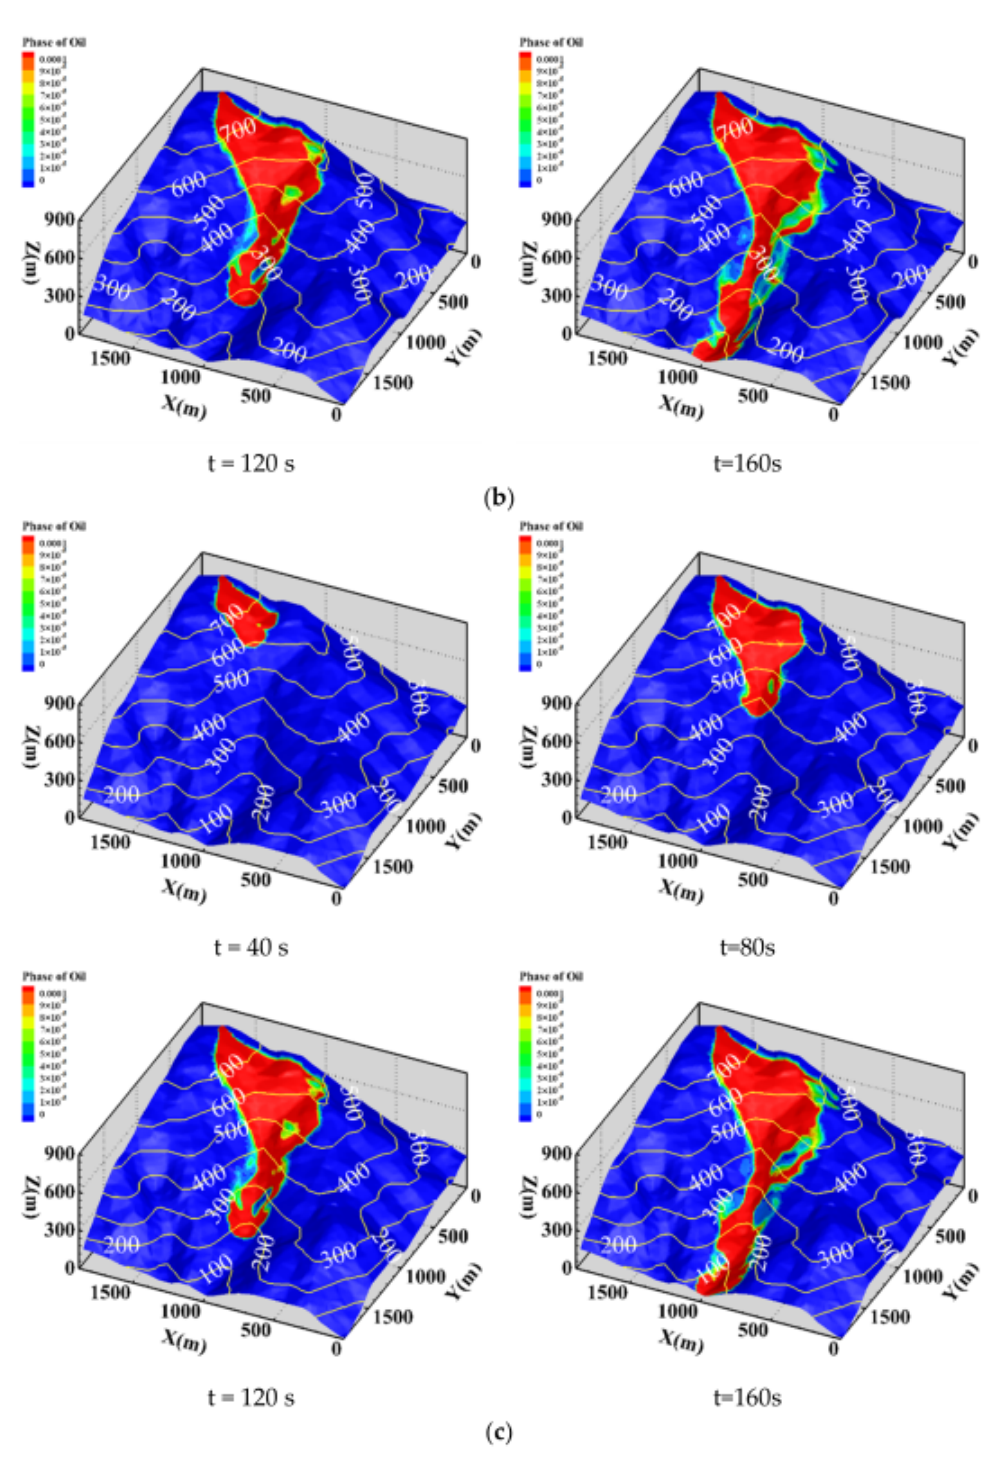
Figure 5. Diffusion patterns of leaked crude oil on different mountain surfaces: ( a ) Rough land; ( b ) Short grass/s; ( c )